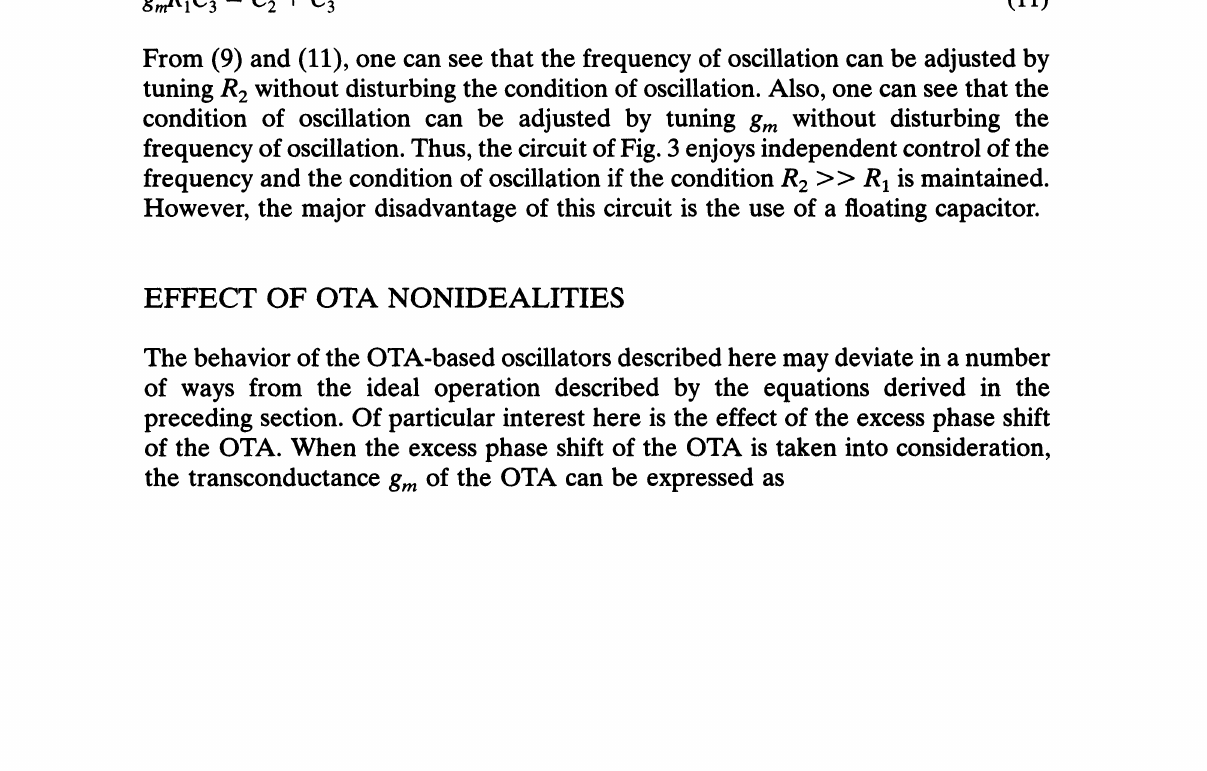
FIGURE 3 Another oscillator circuit obtained from Fig.